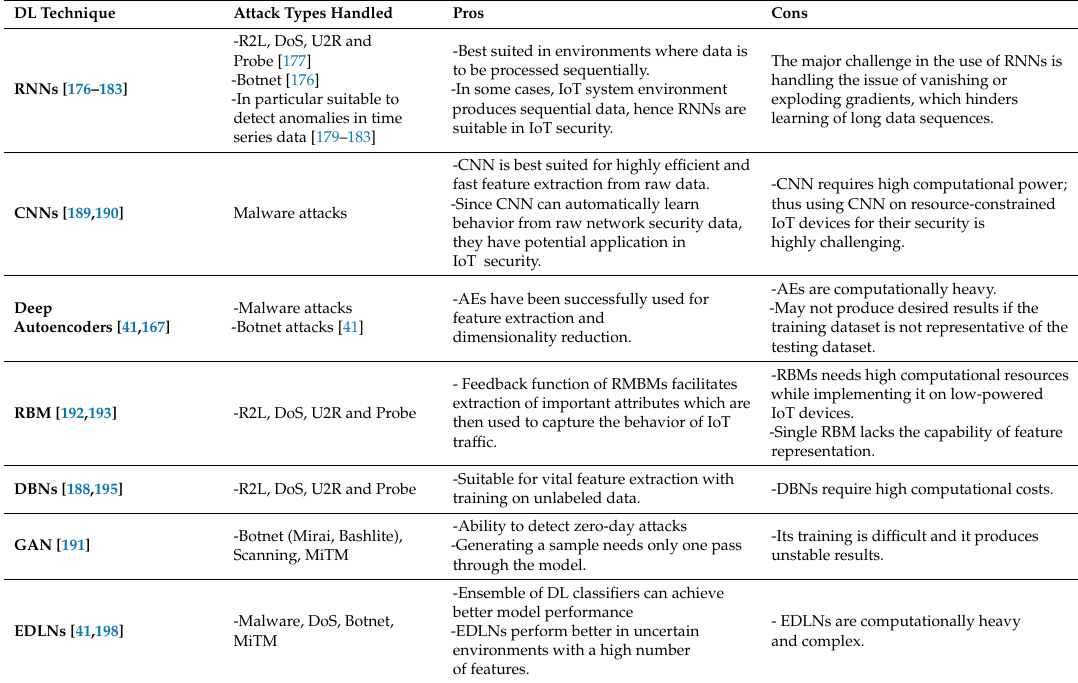
Table 6. Taxonomy of DL based methods for IoT systems